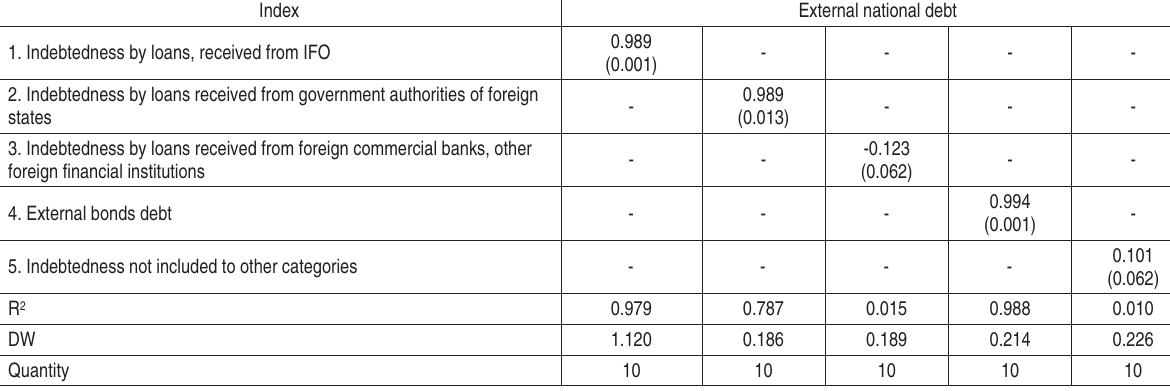
Table 6. The factors of correlation analysis of external national debt dynamics for the 2006-2015